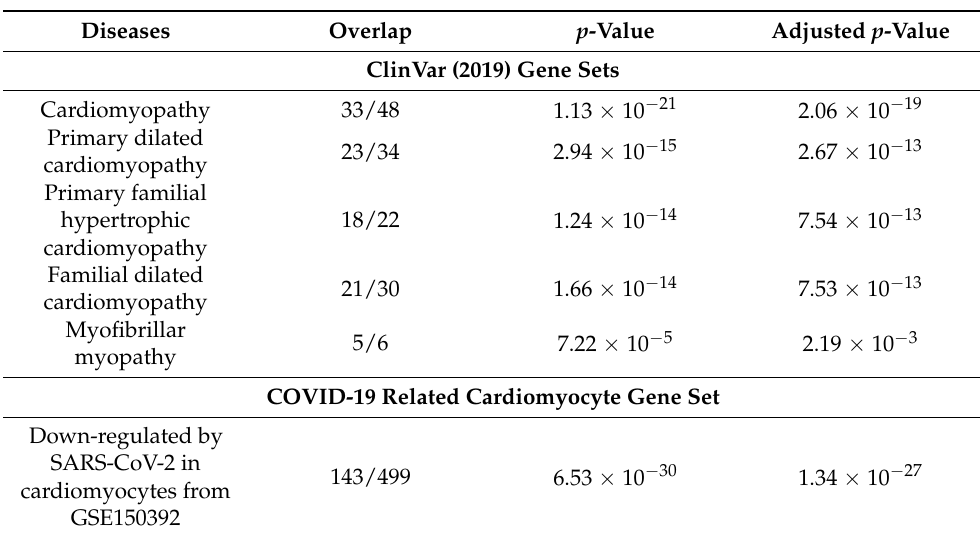
Table 3. Top 5 significantly enriched ClinVar (2019) and one COVID-19-related gene set in significantly upregulated CMs